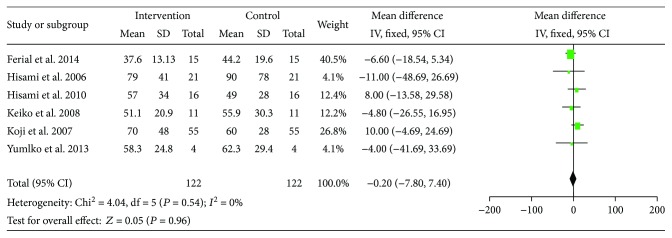
Forest plot for AST.